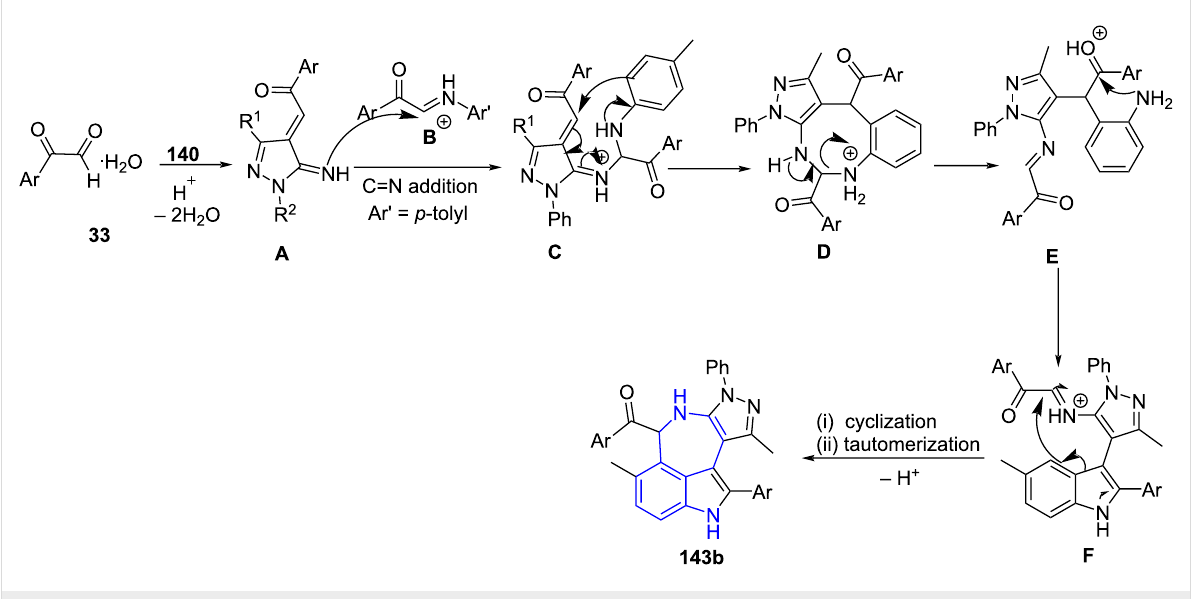
Scheme 59: Proposed mechanism for the synthesis of azepinoindole.